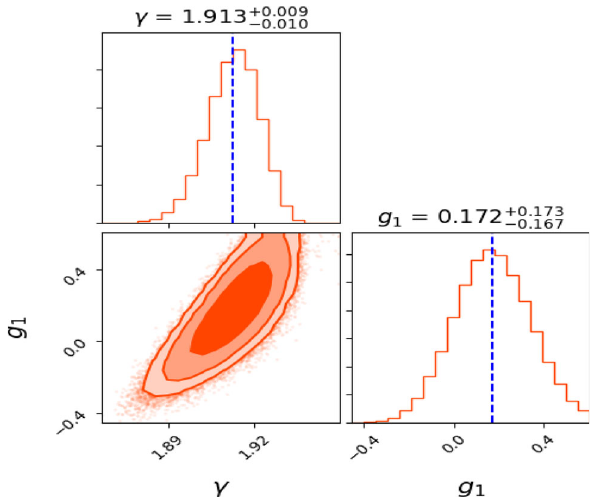
Fig. 4 For Low mass range SGL sample: The 1D marginalized likeli- hood distributions along with 2D marginalized constraints showing the 68%, 95%, and 99% credible regions for the parameters γ (from the power law model describing the SGL systems) and g 1 (from the gas depletion factor g ( z ) ), obtained using the Corner python module [70]